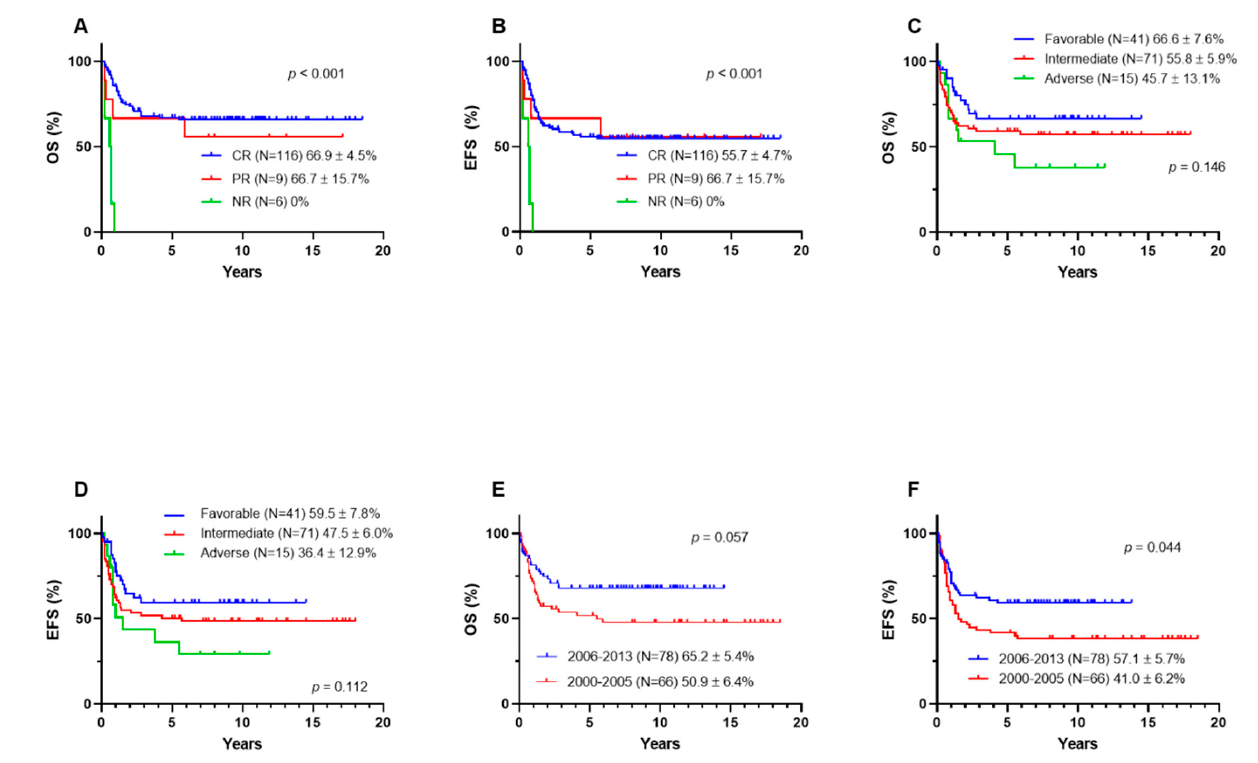
Figure 4. Treatment outcome of study patients. ( A ) OS and ( B ) EFS, according to induction response, ( C ) OS and ( D ) EFS, according to cytogenetics, ( E ) OS and ( F ) EFS, according to period. CR, complete response; PR, partial response; NR, no response; OS, overall survival; EFS, event-free survival.